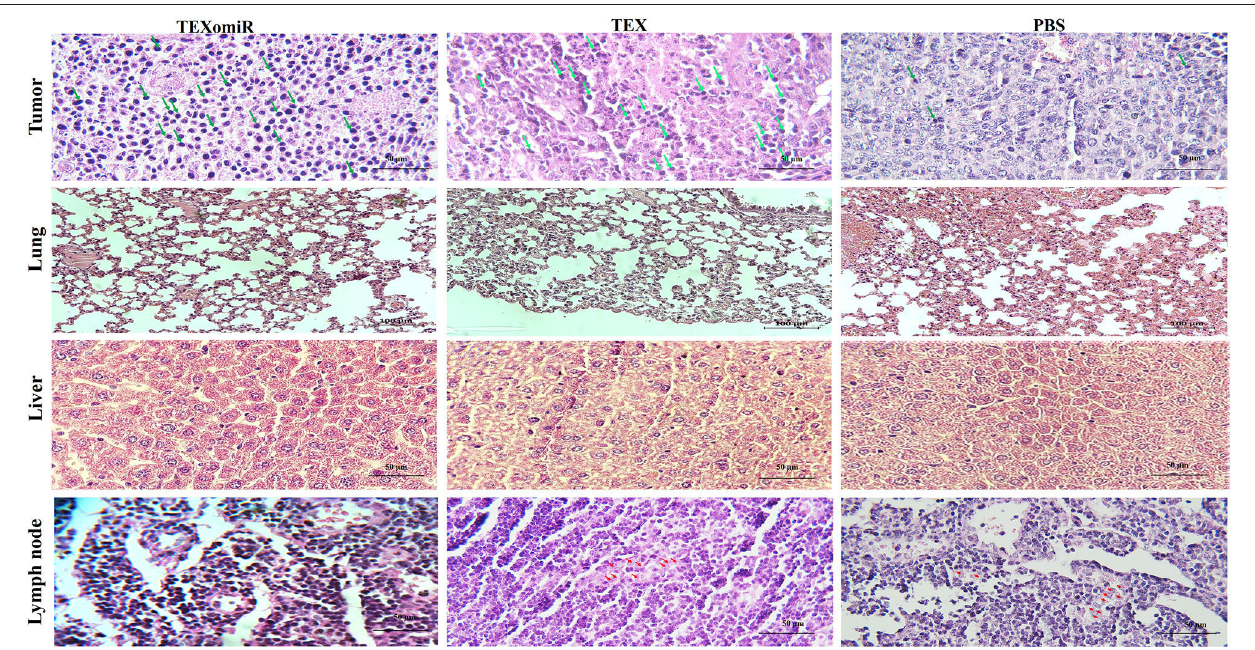
FIGURE 13 | Histopathological results of tumor, lymph node, lung, and liver tissues from CT-26 tumor-bearing mice in different groups. Lymphocyte infiltration in tumor microenvironment (magnification, × 400) and tumor metastasis to lung (magnification, × 200), liver (magnification, × 400), and lymph nodes (magnification, × 400) in the TEXomiR, TEX, and PBS groups. The arrow indicates lymphocyte infiltration in tumor tissue and metastasis to lymph node. The green arrows indicate lymphocyte infiltration, while the red arrows indicate